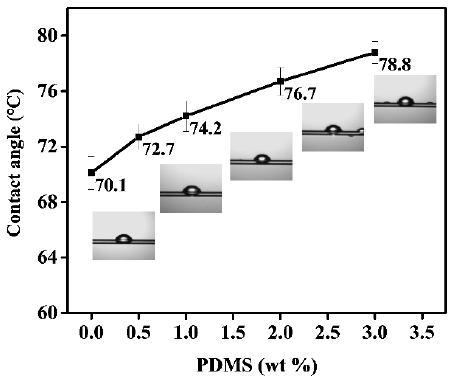
Figure 5. Correlation between PDMS content (%) and contact